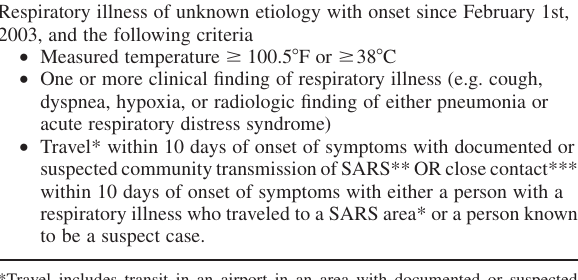
TABLE II CDC definition of suspect SARS case (available at URL http://www.cdc.gov/ncidod/sars/casedefinition.htm) Respiratory illness of unknown etiology with onset since February 1st, 2003, and the following criteria † Measured temperature $ 100.5 8 F or $ 38 8 C † One or more clinical finding of respiratory illness (e.g. cough, dyspnea, hypoxia, or radiologic finding of either pneumonia or acute respiratory distress